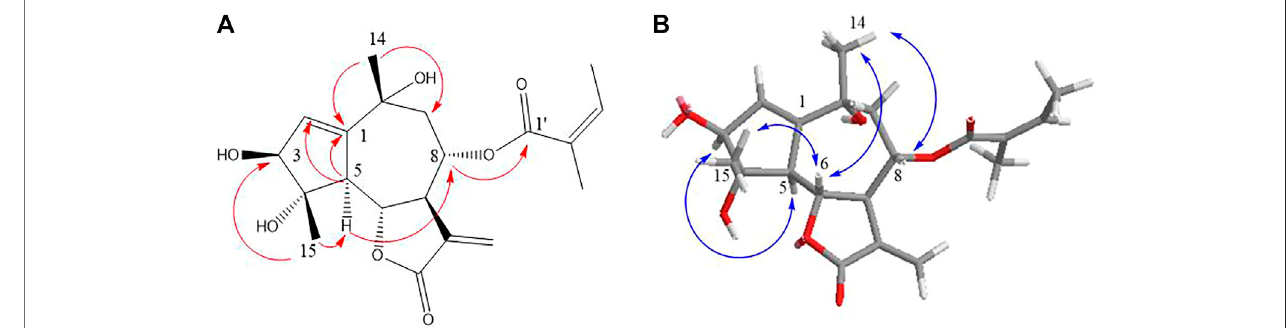
FIGURE 6 | Key HMBC (A) and NOESY (B) correlations of compound 3 .